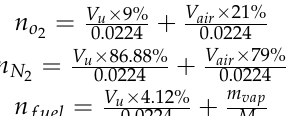
1 #2 # Figure 14. Variation in oxygen concentration (volume fraction) in the fuel tank with velocity sub- jected to inert fragments with different masses. The curves in the non-shaded parts in Figures 13 and 14 represent the variations in oil–gas and oxygen concentrations in the fuel tank, respectively (the shaded part indicates that the fuel tank has been disassembled and is no longer suitable for the variation in gas concentration in this model). In tests No. 1–7, the oxygen concentration inside the tank was lower than the LOC (12%), so the fuel could not be ignited. This is consistent with the test results. In addition, it can be seen from Figure 13 that under the high-velocity impact